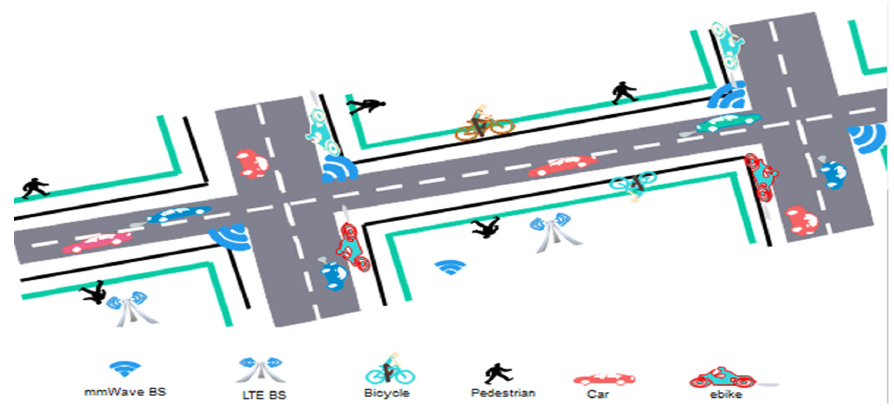
Figure 1. Multiuser type mobility model.